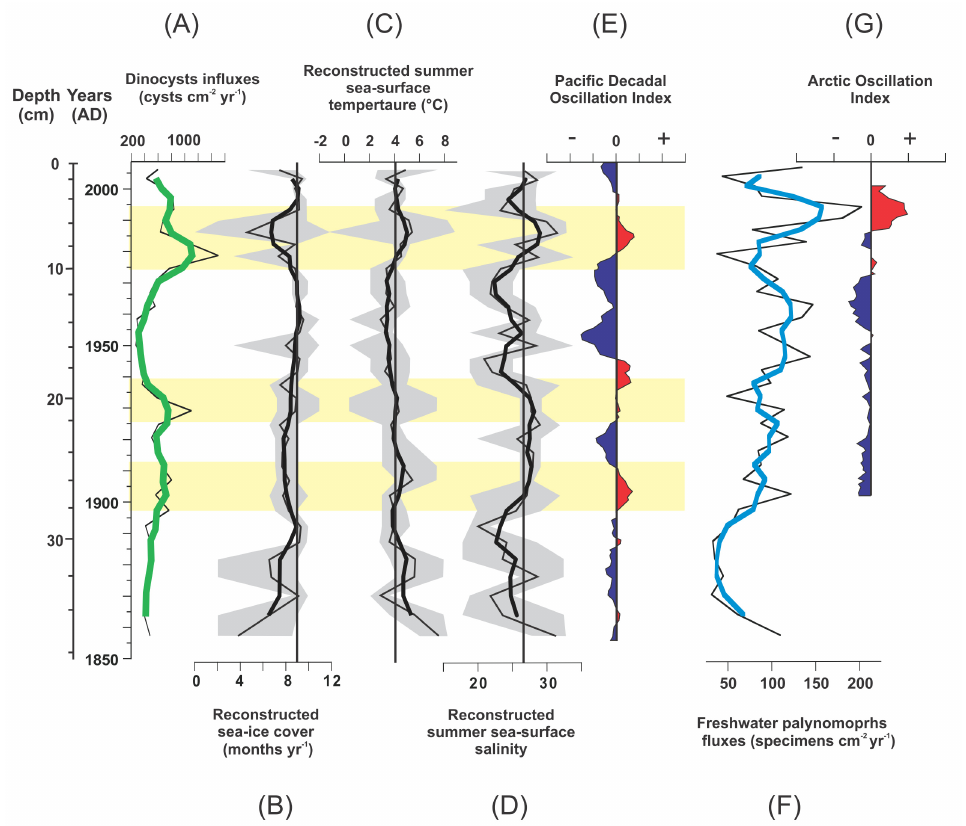
Fig. 6. Dinocyst fluxes and reconstructed sea-surface parameters in core MA680BC, and climate indexes plotted against depth and age AD. Dinocysts fluxes (A) ; reconstructed sea ice cover (B) ; reconstructed temperature (C); reconstructed salinity (D) ; Pacific Decadal Oscillation (PDO) normalised index (E); freshwater palynomorph fluxes (F); Arctic Oscillation (AO) normalised index (G) . The modern values of sea- surface parameters are represented by the vertical line. The grey areas represent the confidence interval (minimum and maximum possible values) for each reconstructed parameter. The horizontal yellow areas represent warm intervals associated with positive and negative phases respectively for the PDO index (Mantua and Hare, 2002). The thick curves represent a running average over 3 data points. Both PDO and AO indexes are averaged over 5 data